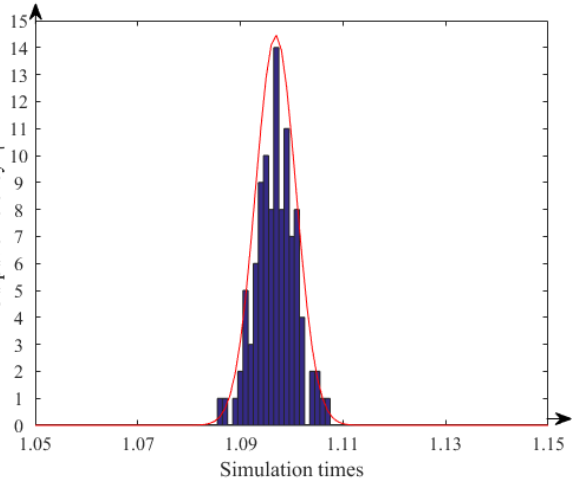
Figure 17. The distribution of the functional requirement value of the separate TCM function unit. The collect TCM and output TCM function units can use the complexity prediction model to obtain their function realization probability. In the input of their prediction mod- els, the changed physical parameter is disintegrating slag rate, which is the main factor